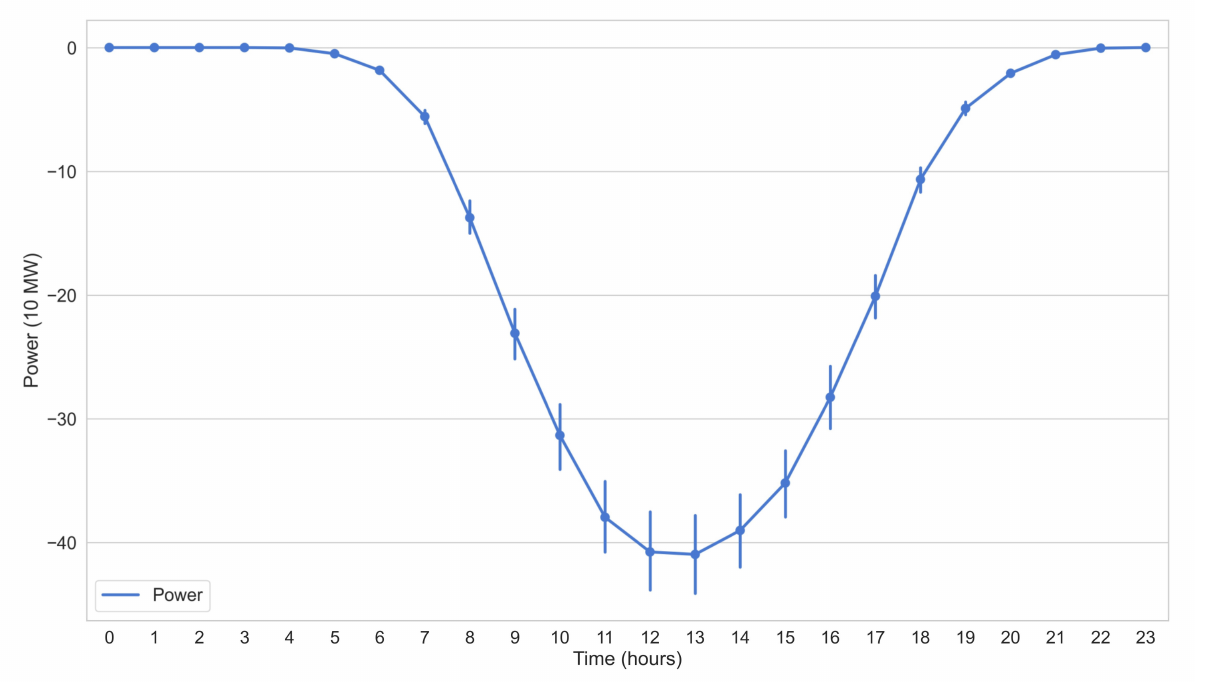
Figure 7. Hourly power output from Photovoltaic Panel.